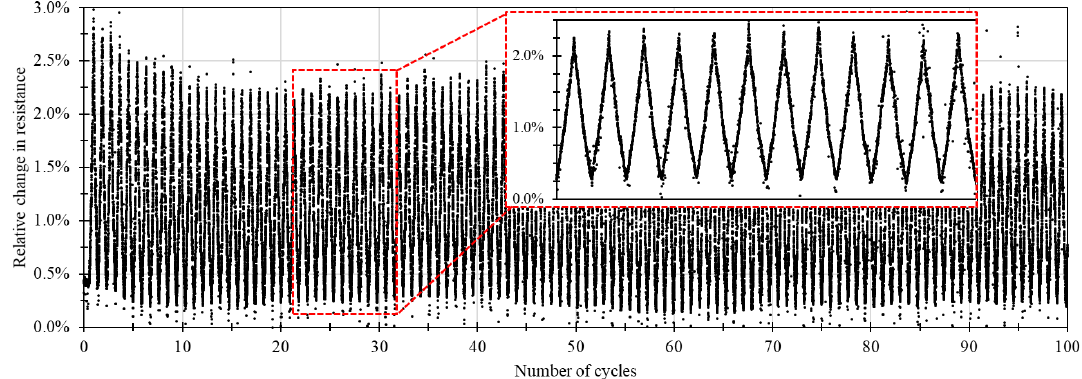
Figure 11. Response of the hybrid sample under cyclic strain loading test.